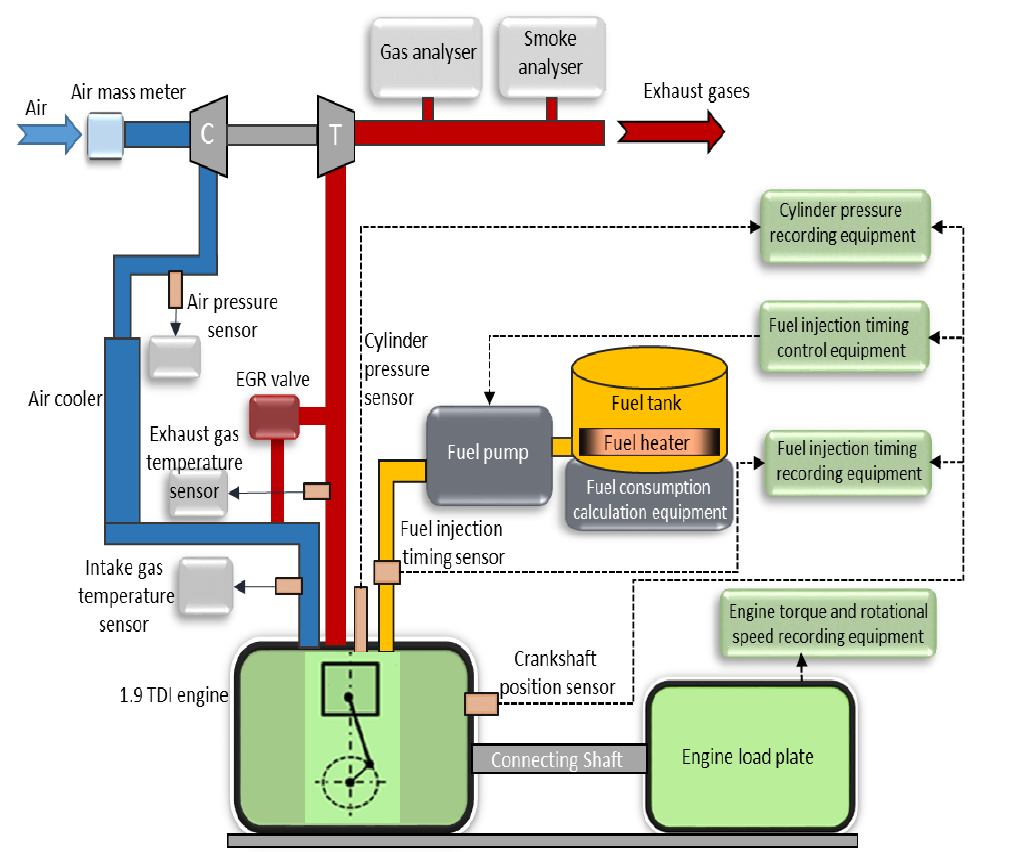
Figure 2. Schematic internal combustion engine testing equipment.